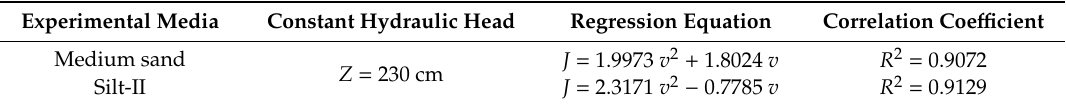
Table 4. Polynomial equations and correlation coe ffi cients for medium sand and silt-II.